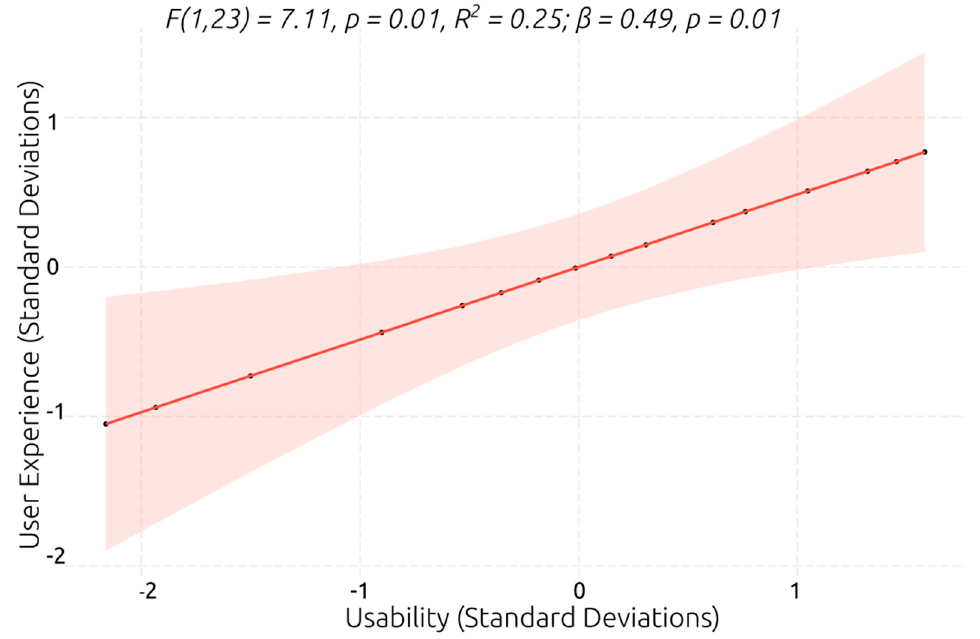
Figure 13. Best linear regression model for predicting user’s experience.